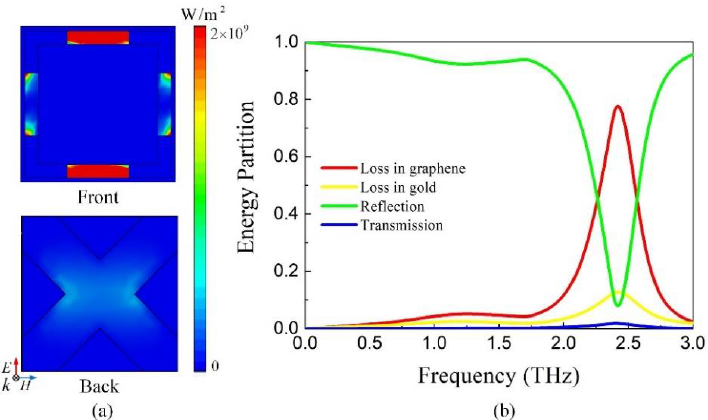
Figure 9. ( a ) The power loss distribution of the narrowband frequency-tunable absorber at 2.48 THz with E F = 0.3 eV ( b ) The energy partition of the narrowband frequency-tunable absorber at 2.48 THz with E F = 0.3 eV.